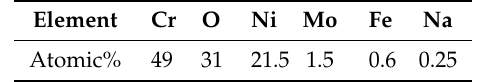
Table 7. Chemical composition at Inconel 625 surface after machining and EB welding, untested.